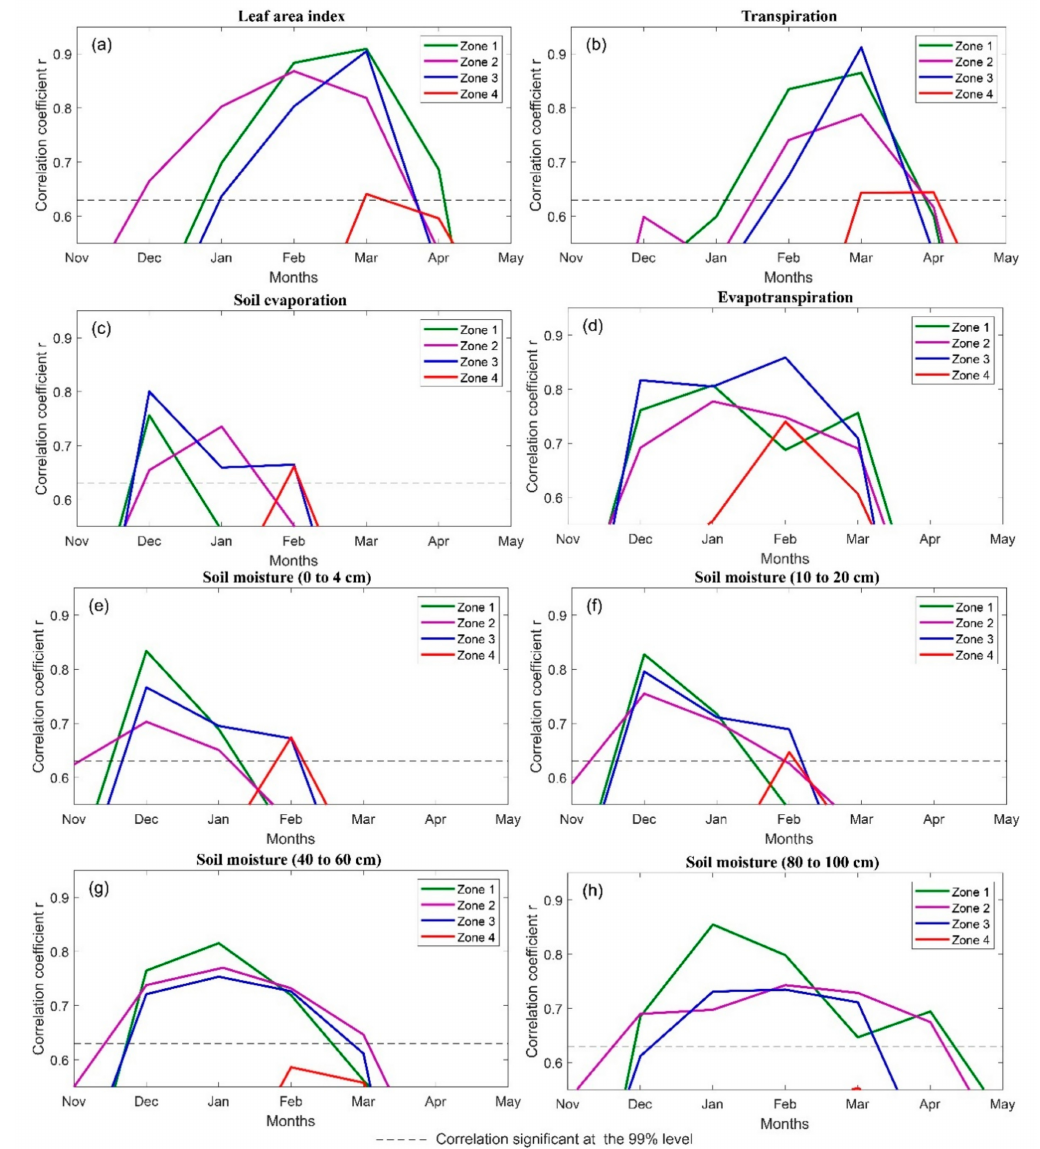
Figure 6. Lagged correlation between the LDAS output anomalies of the LAI ( a ), transpiration ( b ), soil evaporation ( c ), evapotranspiration ( d ), SM at (0 to 4 cm) ( e ), SM at (10 to 20 cm) ( f ), SM at (40 to 60 cm) ( g ), SM at (80 to 100 cm) ( h ) and the cereal yield for all